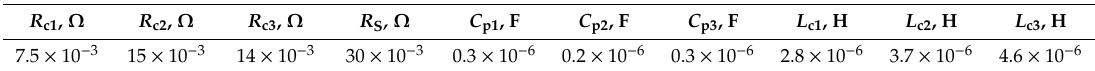
Table 1. Parameters of the solar panel elements.